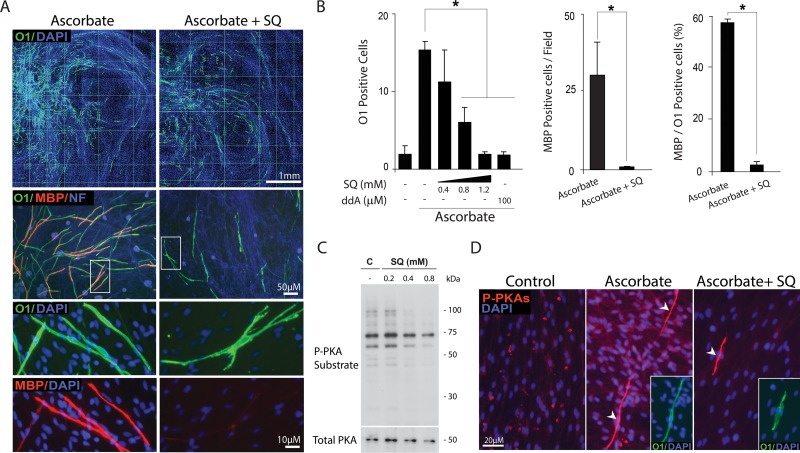
Reduction of O1 and MBP expression by pharmacological inhibition of the tmAC.SC-neuron cultures were induced to produce myelin by treatment with ascorbate in the absence (Control) or presence of SQ22536 (SQ), which was provided at 0.8 μM unless otherwise indicated. Treatment was carried out for 12 days (A-B) and 5 days (D), respectively. Cultures were analyzed for their expression of O1 and MBP (A-B) or O1 and P-PKA-specific substrates (D) by immunofluorescence microscopy. A quantification of O1 and MBP expression is provided in B, which also includes a condition where mtAC activity was inhibited by dideoxy-adenosine (ddA). As shown in A, some SCs displayed high levels of cell surface O1 even in the presence of SQ22536. However, these cells did not convert into myelinating cells, as denoted by their multiple processes (indicative of failure to establish a one-to-one association with axons) and lack of MBP expression. The dose dependency of P-PKA substrate expression by increasing concentrations of SQ22536 was confirmed by western blot analysis in SC-only cultures (C). The arrowheads in B indicate a source of P-PKA substrate immunoreactivity exclusively present in differentiating O1 positive cells (boxes) that was insensitive to inhibition by SQ22536.